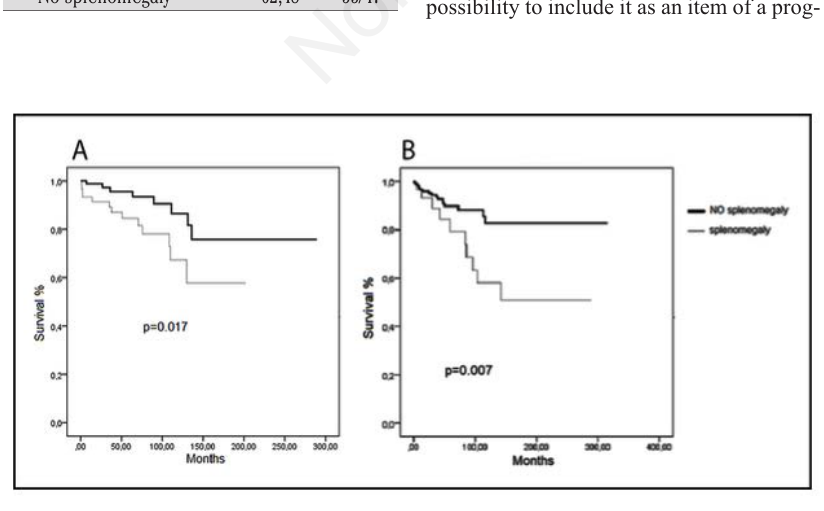
Figure 1. Survival in patients with splenomegaly versus patients without splenomegaly at diagnosis. In PV patients (A) and ET patients